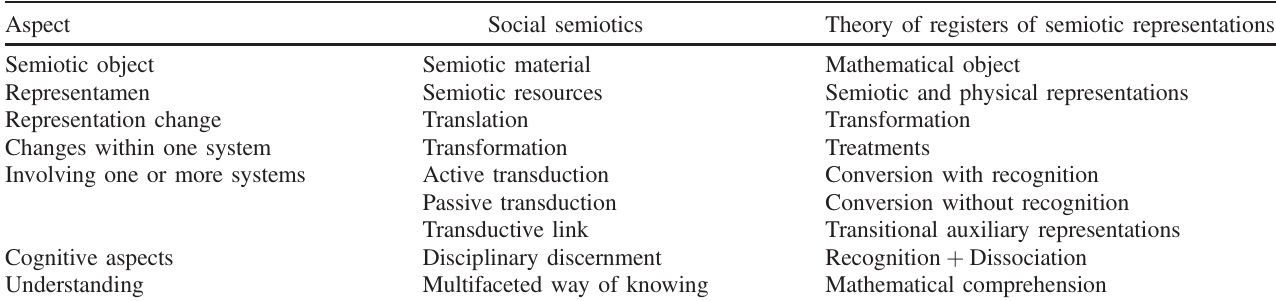
TABLE I. Similarities between social semiotics and the theory of registers of semiotic